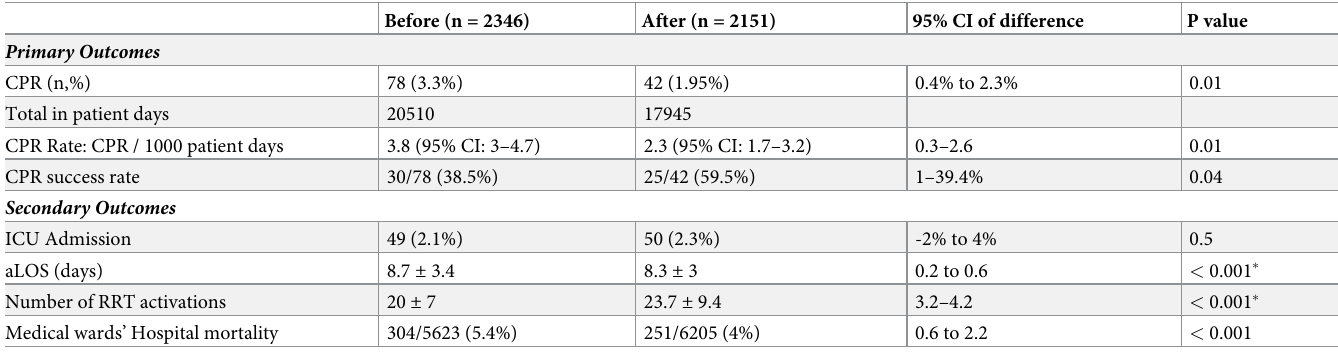
Table 2. Primary and secondary